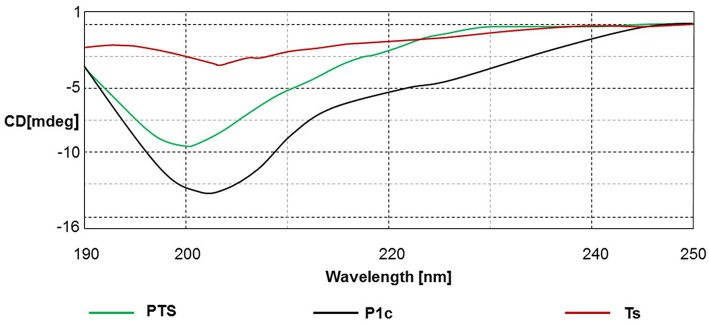
The CD spectra of the peptides in TFE/H2O buffer (1:1, v/v).